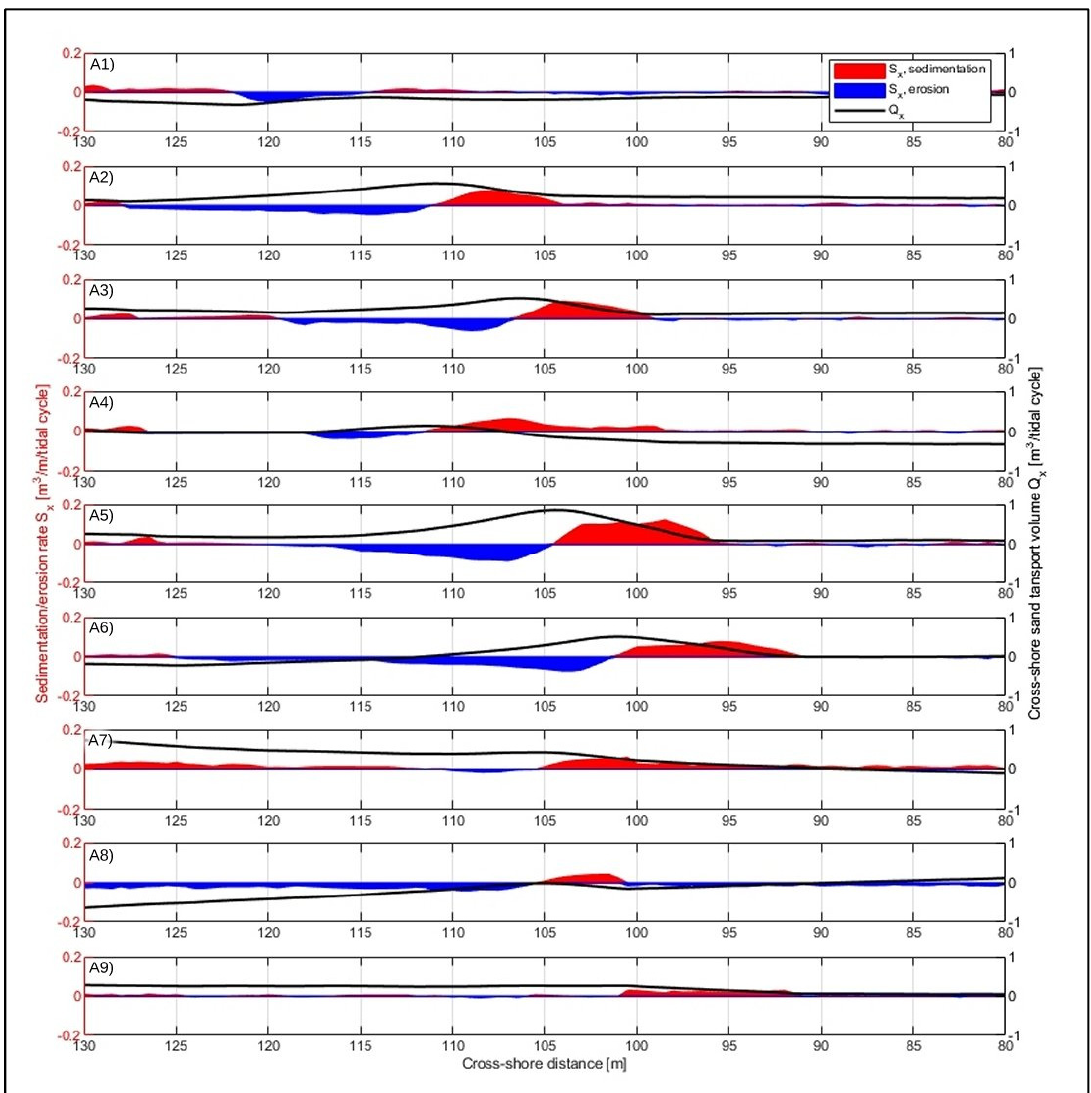
Figure 9 . Low waterbed levels for period A (M1 in Figure 7) from 21 to 26 January 2017. The dashed lines indicate the total high water level after each subsequent low water period. A1–A9 indicates time periods shown in Figure 10.